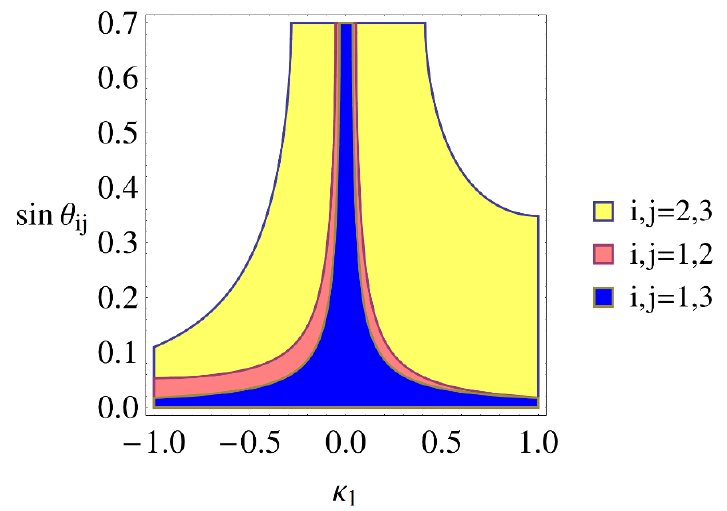
Figure 5. Regions of the (cid:20) coupling parameter space allowed at 95% con(cid:12)dence level by measure- (cid:22) K 0 and B (cid:22) B ments of K 0 mixing. The three regions correspond to the sets of parameter ( d;s ) (cid:0) ( d;s ) (cid:0) choices given in eqs. (4.3){(4.5).